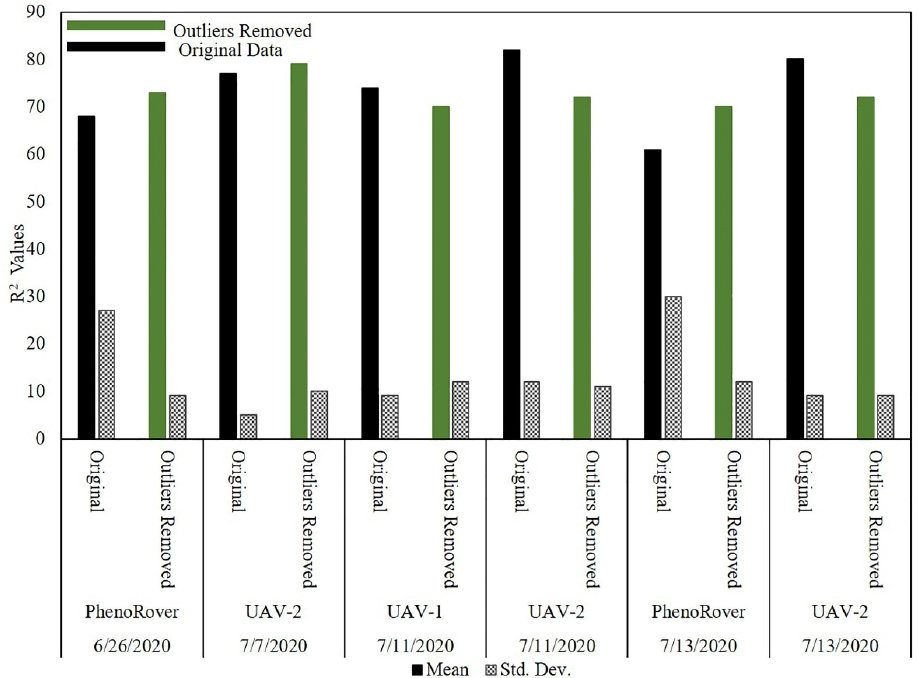
Figure 24. Maize LAI estimation on original and datasets with PointCleanNet outlier removal during the growing season on UAV and PhenoRover.